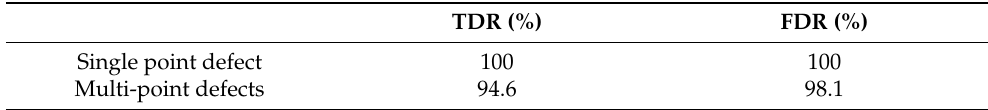
Table 3. Metrics of our proposed